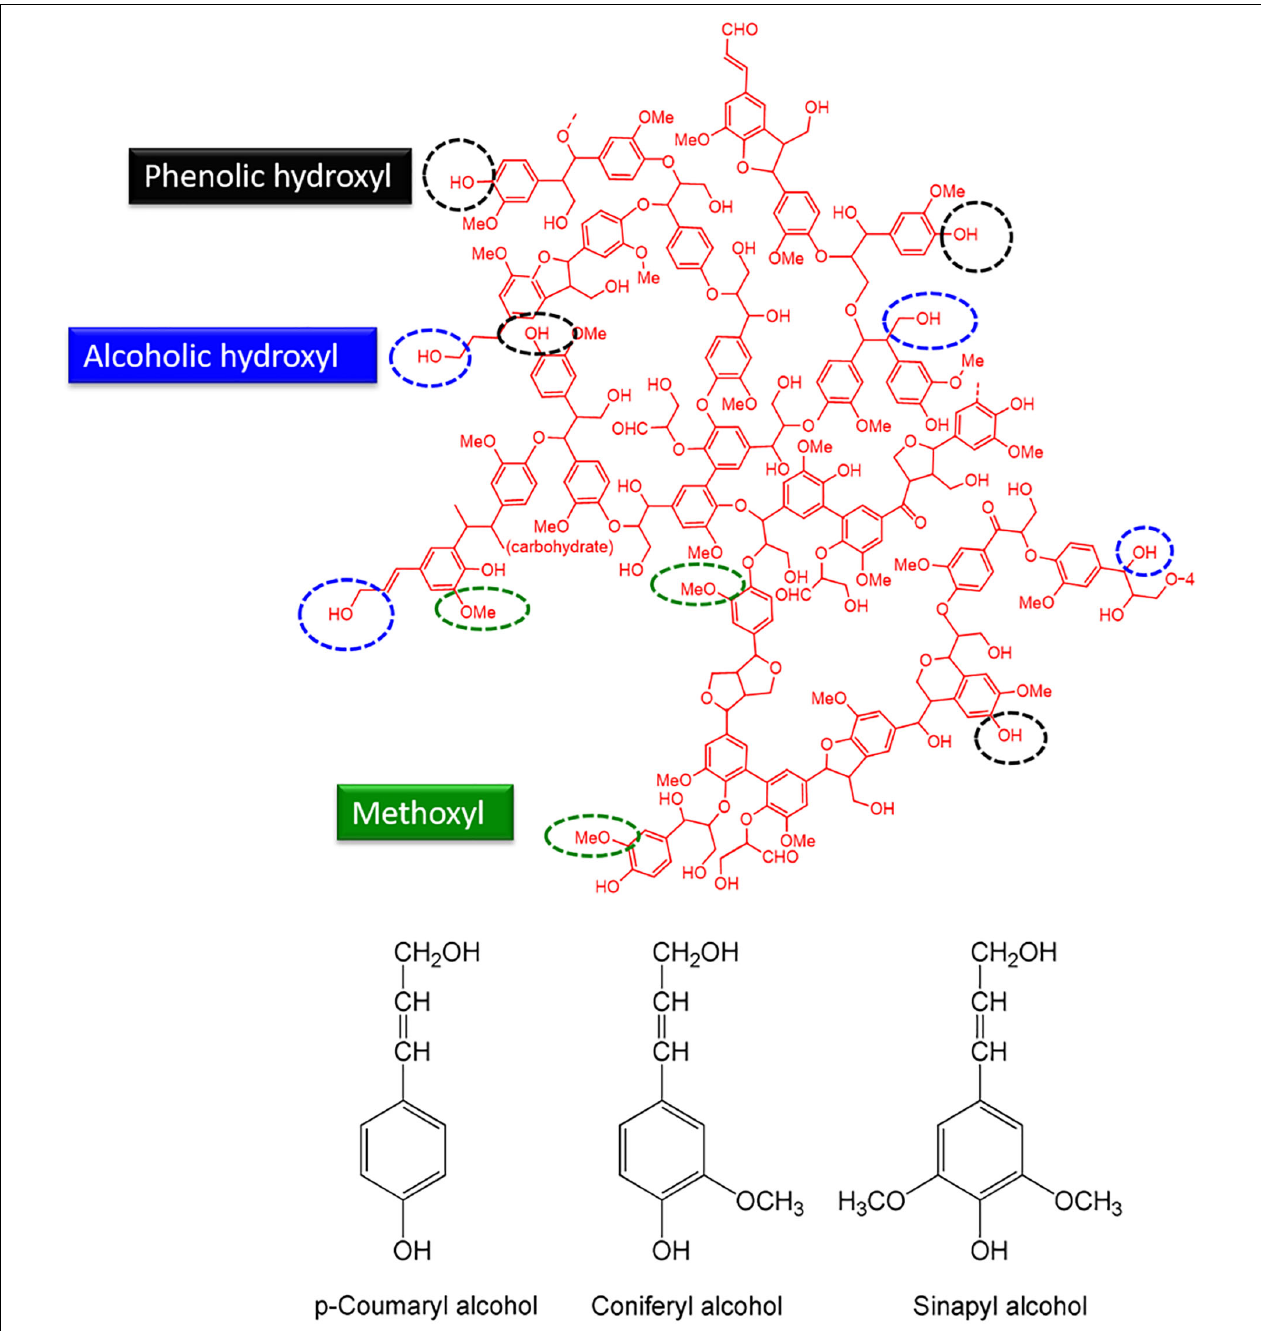
FIGURE 2 | Proposed structure of lignin with the main functional groups and the monomers of lignin (Fang et al., 2017a) with permission from The Royal Society of Chemistry (Order license ID: 1029450-1).